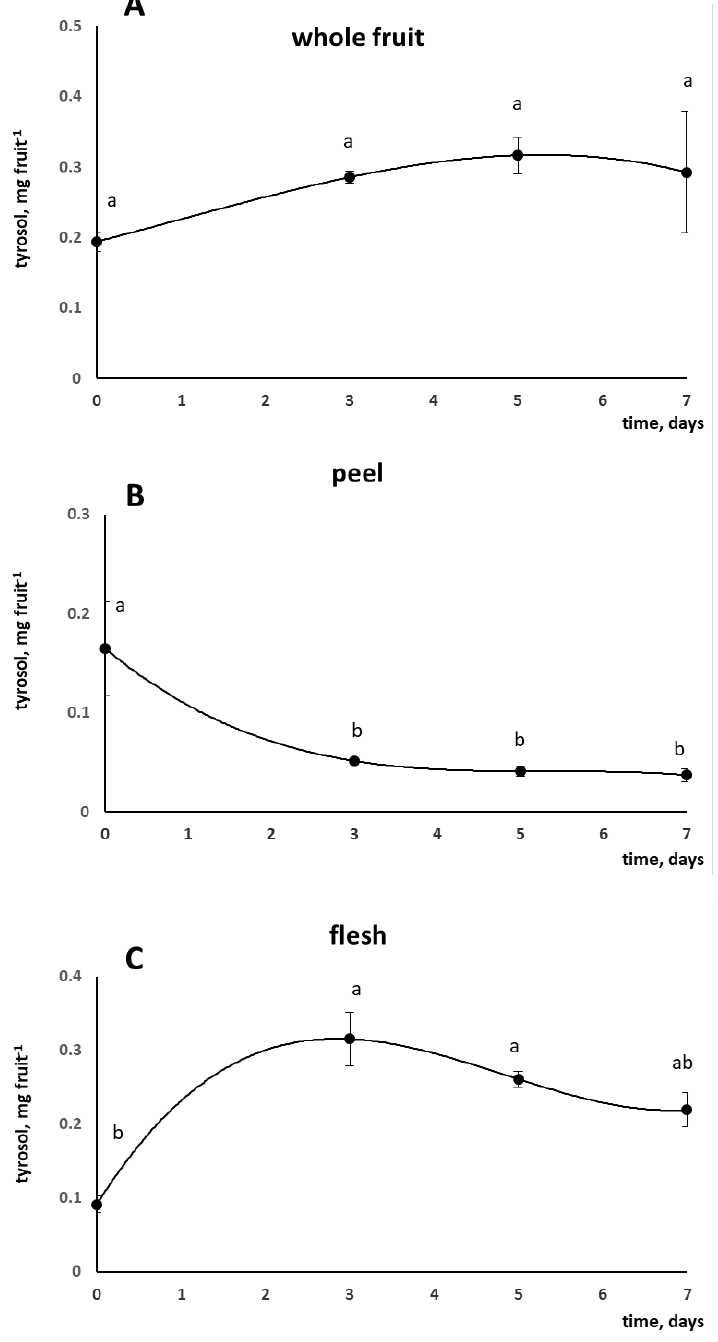
Figure 2. Tyrosol content (mg fruit -1 , mean ± SE) of whole tomato fruit ( A ), peel ( B ) and flesh ( C ) at different storage times. Different letters indicate statistically significant differences, according to one-way ANOVA, followed by Tukey – Kramer post hoc test ( p < 0.05).